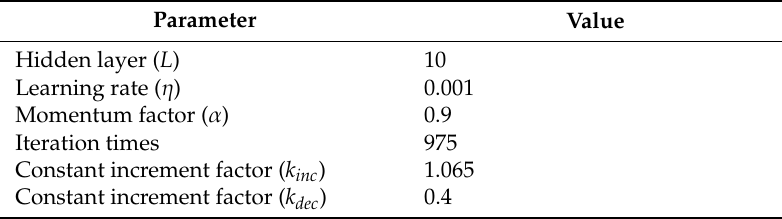
Table 4. Parameters of the neural network with the arbitrary training data